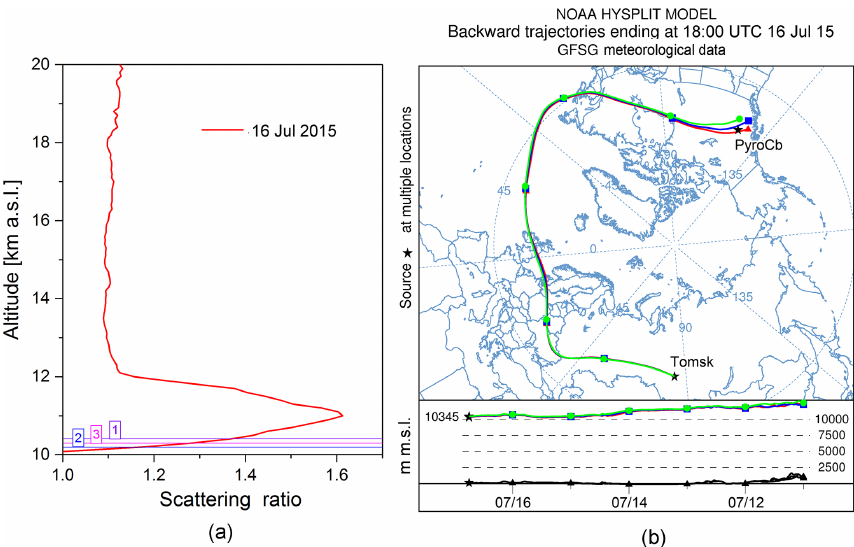
Figure 6. (a) Detection of a pyroCb plume from British Columbia in the TR–LS over Tomsk. The numbers 1–3 indicate the tropopause alti- tudes estimated in Kolpashevo, Emeljanovo, and Novosibirsk, respectively, at 18:00UTC on 16 July 2015. (b) Air mass backward ensemble trajectories started from altitude of 10.3–10.5km over Tomsk at the same time.